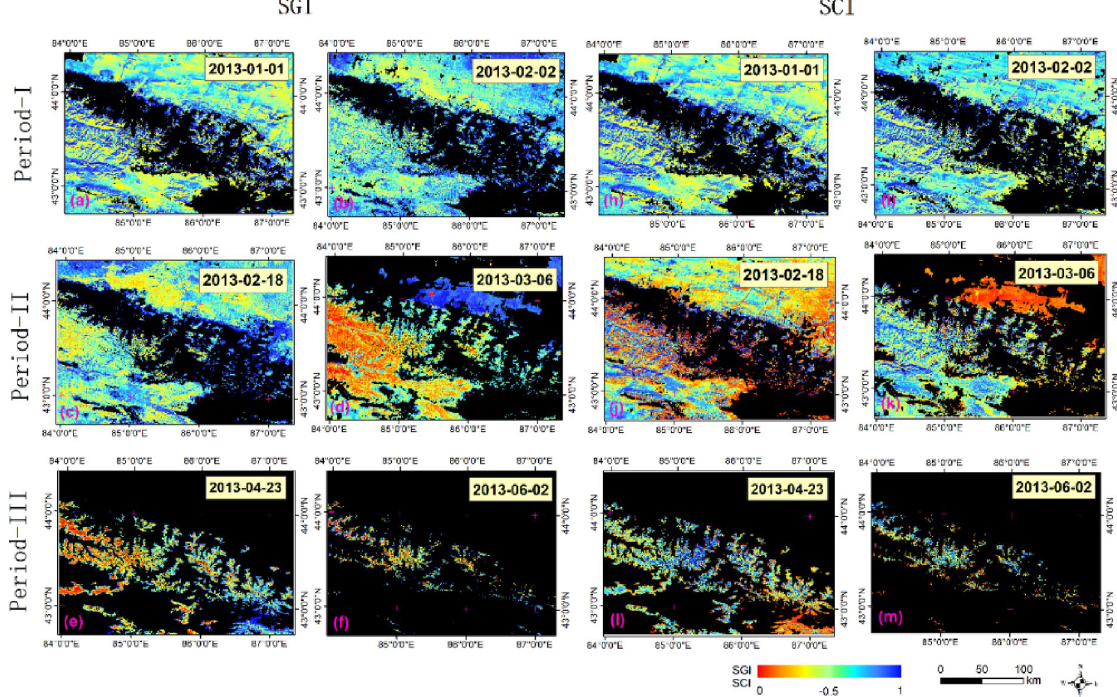
Figure 4. Spatiotemporal distributions of the SGI and SCI during snowmelt periods in 2013. ( a – f and h – m ) are the SGI and SCI that calculated from the reflectance data of MOD09GA (https:// ladsw eb. modaps. eosdis. nasa. gov/) and snow cover area data of MOD10A1 (http:// www. crens ed. ac. cn/ portal/). Map created in ArcMap 10.6 of the Environmental System Resource Institute, Inc. (https:// www. esri. com/ softw are/ arcgis/ arcgis- for- deskt